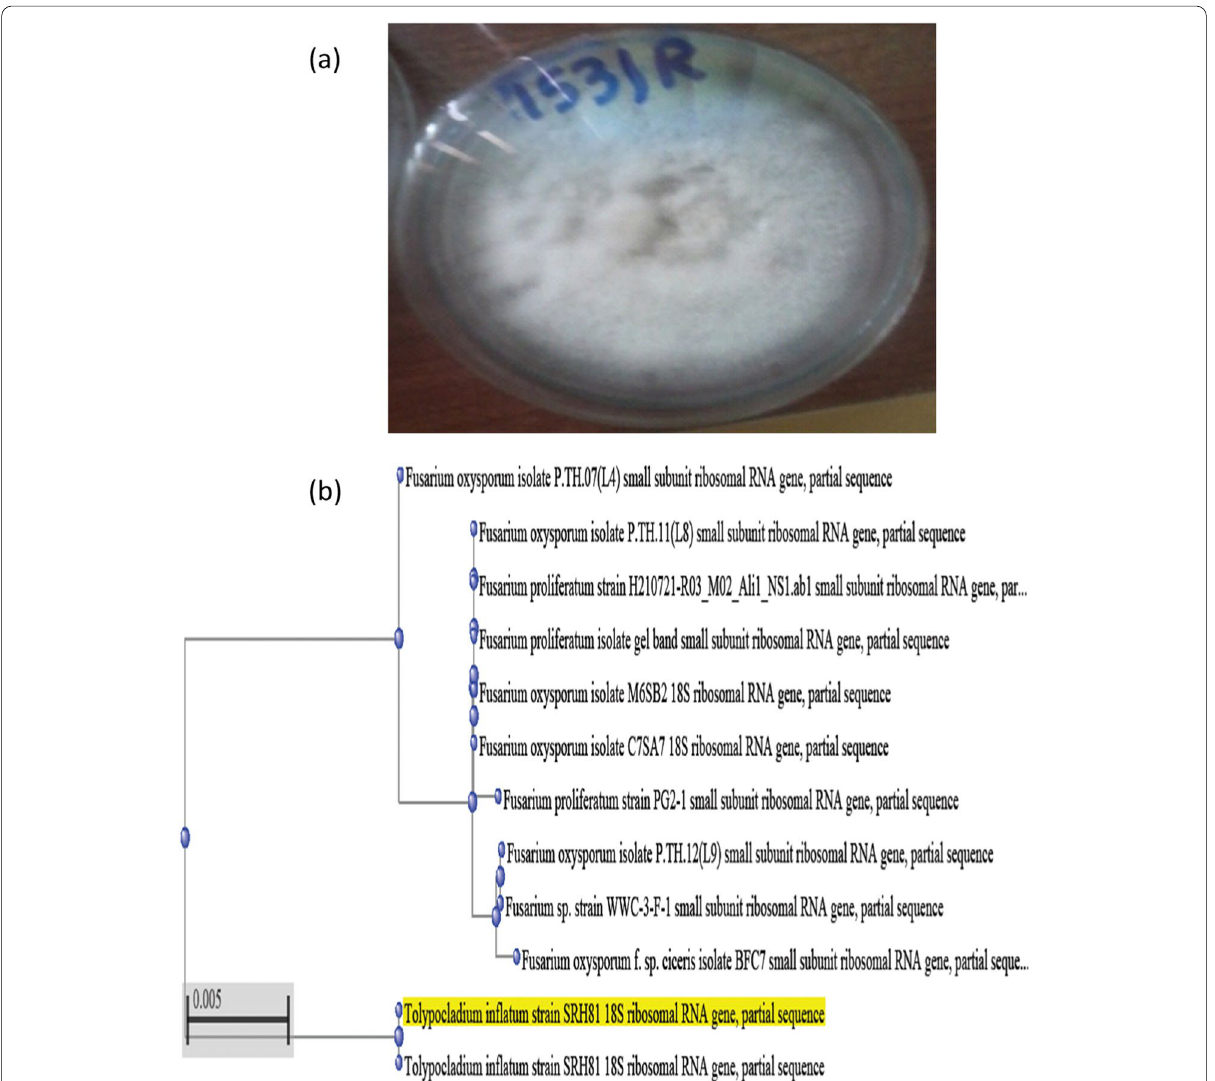
Fig. 1 Colony morphology on potato Czapek’s agar (PDA) media ( a ) and Neighbor-joining phylogenetic tree ( b ) of Tolypocladium